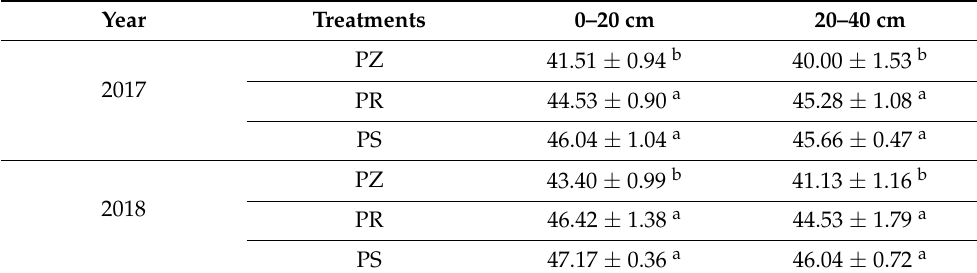
Table 3. Soil porosity of plough layer under different tillage methods